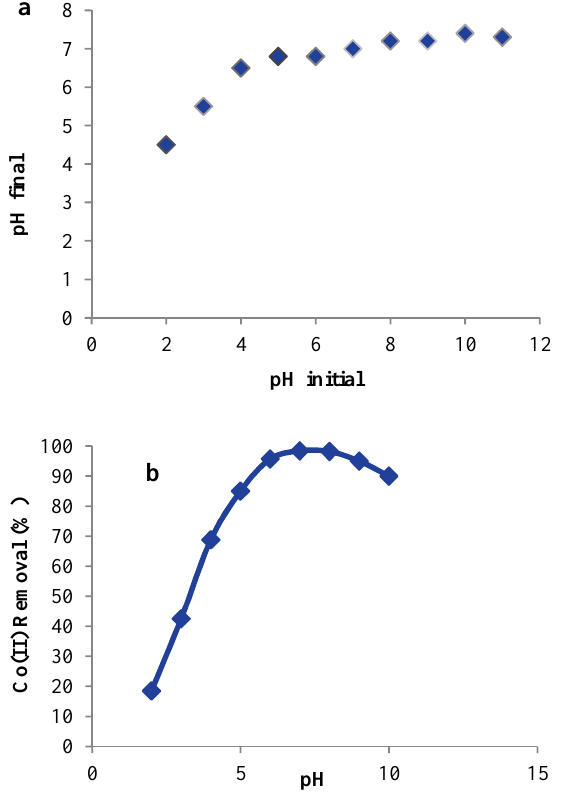
Figure 4. (a) The determination of the point of zero charge of the NiFe O nanoparticles (b) 2 4 Effect of solution pH on the removal efficiency of Co(II) by NiFe O nanoparticles (C = 60 mg/l, 2 4 0 contact time = 70 minutes, dose of adsorbent = 0.02 g, and temperature = 25